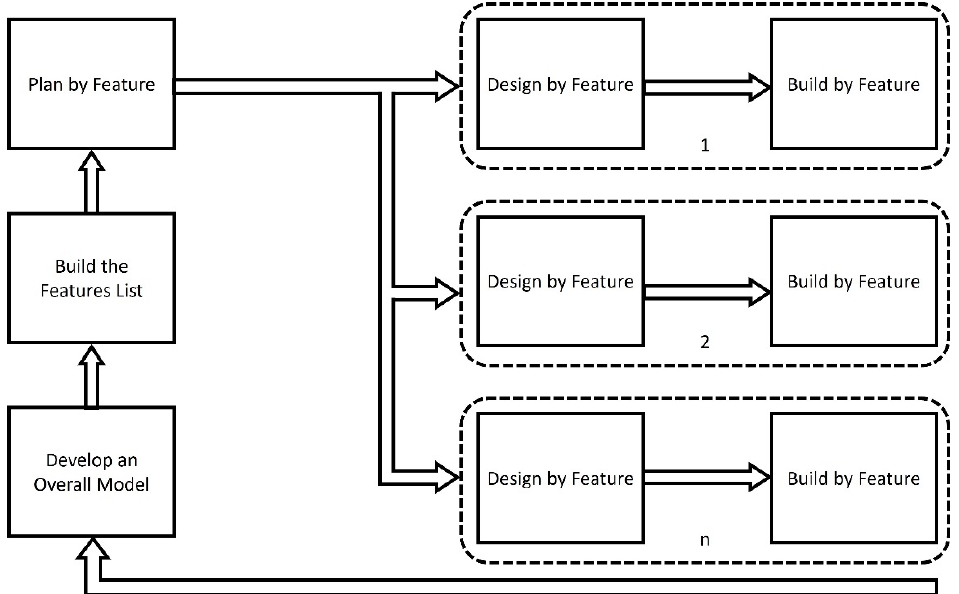
Figure 3. FDD development cycle—part of Agile methodologies.